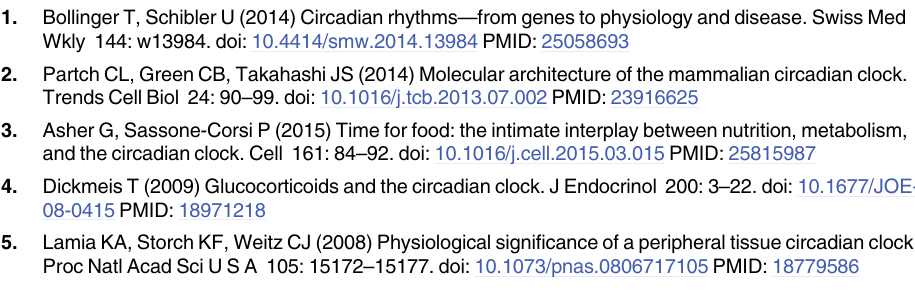
S1 Table. RNA-Seq analysis results. S2 Table. UPLC-FLR and IC-CD data overview. S3 Table. List of zebrafish metabolic pathway genes S4 Table. Bucket tables for NMR